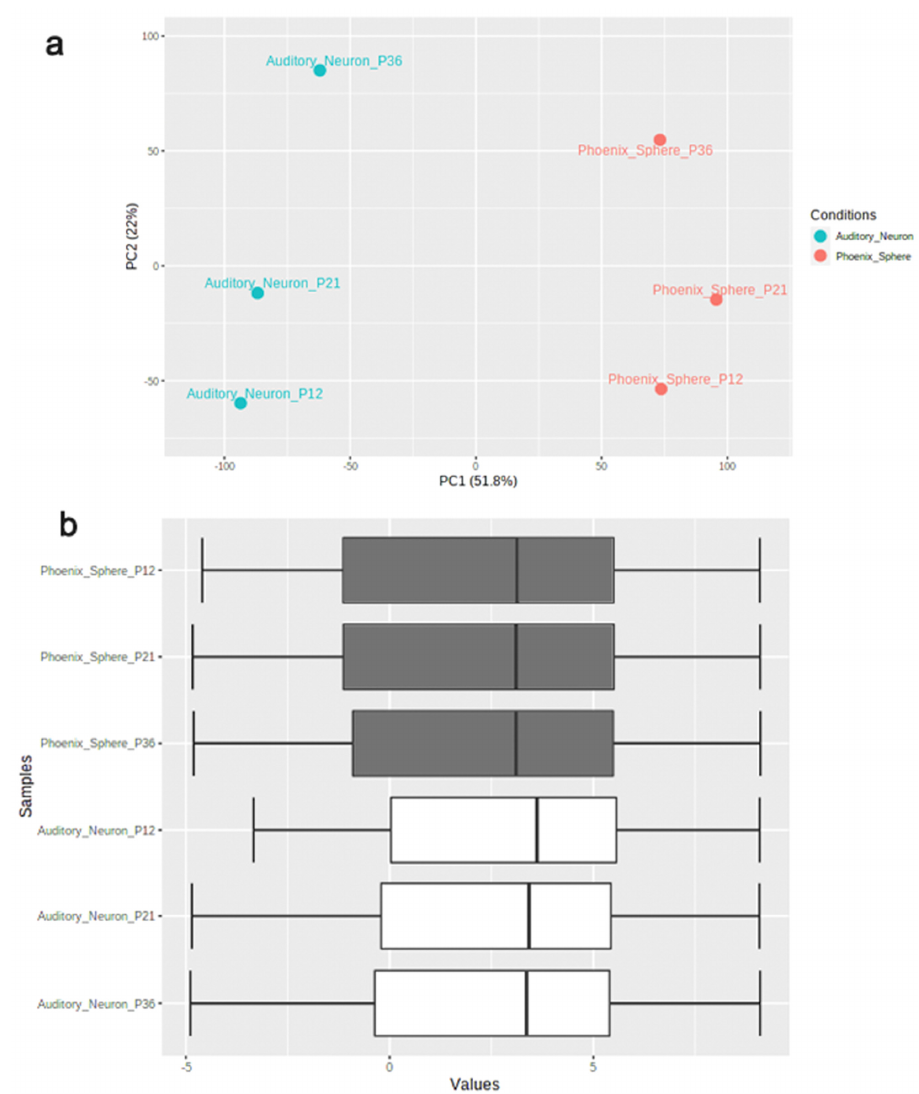
Figure 1. Data quality control of phoenix sphere and auditory neuron samples. ( a ) PCA plot displays that the phoenix sphere and auditory neuron samples were clearly divided into two clusters; ( b ) the quantile normalisation boxplot of samples. Vertical black lines in the boxes represent